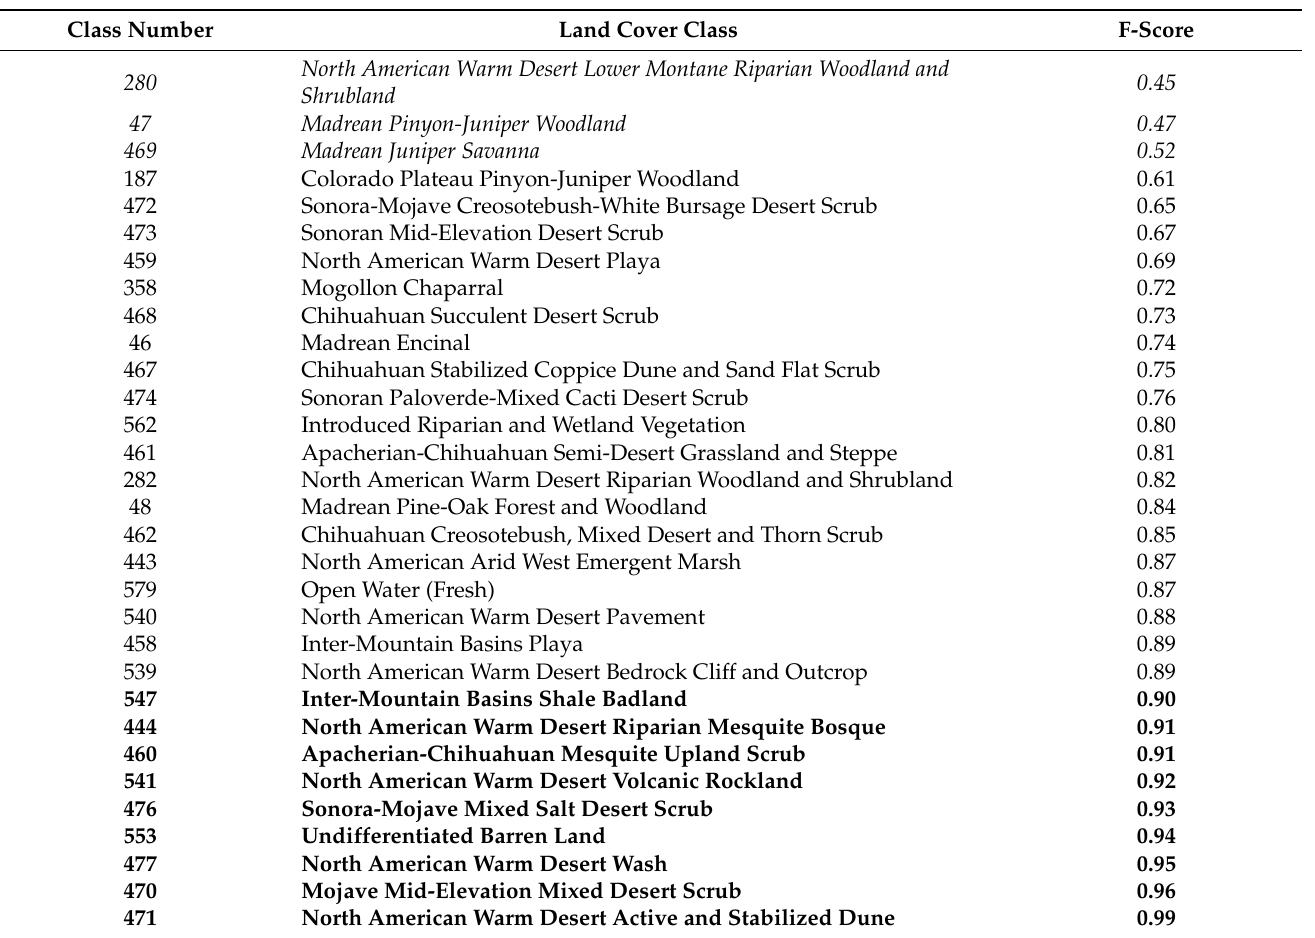
Table 4. F-score results for all land cover classes generated from the RF model. These results are obtained from the testing dataset created from labeled GAP data in the US portion of the study area. Top performing classes with an F-score greater than or equal to 0.9 are bolded and the lowest performing classes with an F-score below 0.6 are